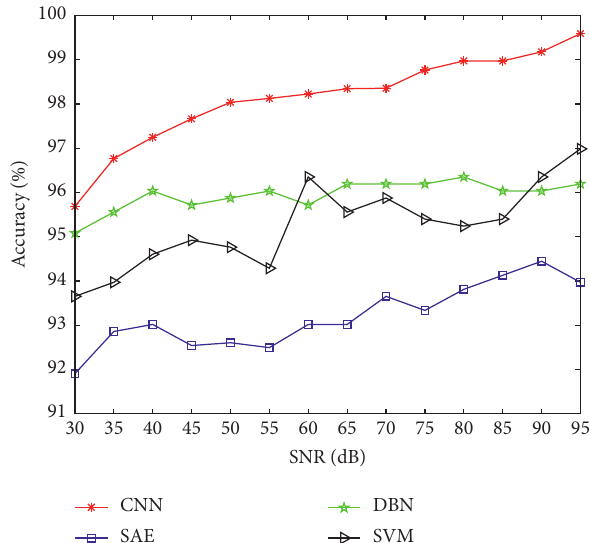
Figure 12: Classification accuracy of classifiers under different